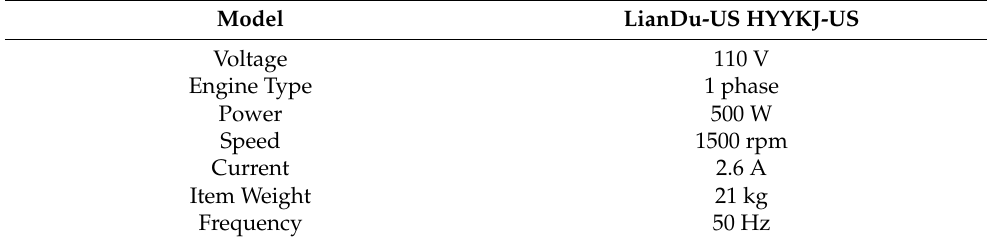
Table 6. Characteristics of the selected hydroelectric turbine.